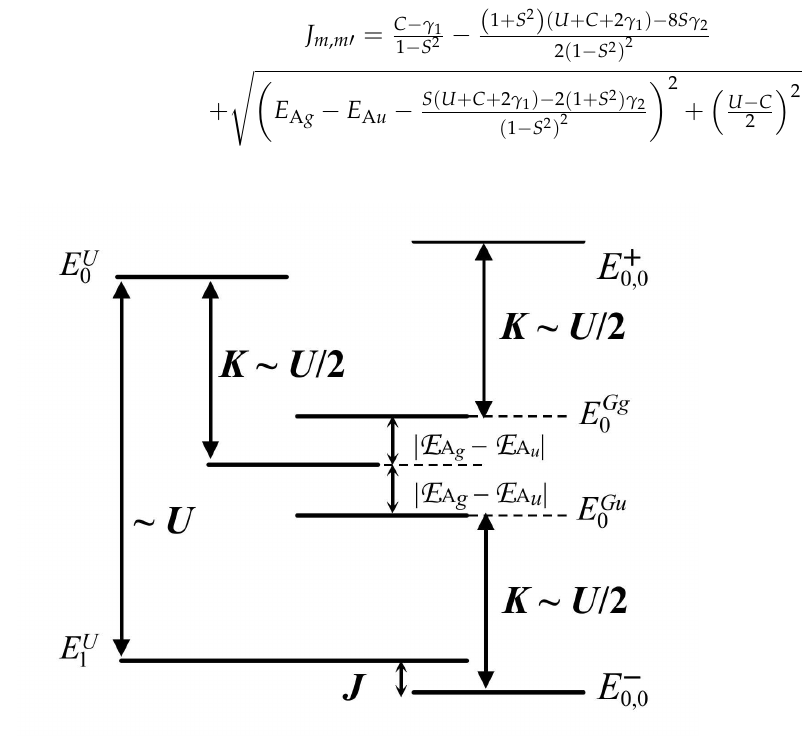
Figure 4. Energy level scheme for the AXB centrosymmetric system (with here A = B for the sake of simplicity) in the case of dominant coulombic interactions; the difference | E A g − E A u | has been artificially zoomed for clarity. J is given by Equations (39) and